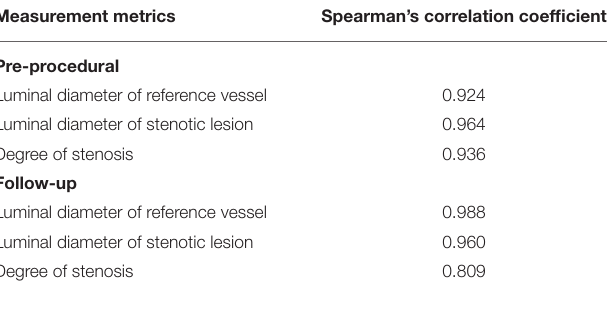
TABLE 4 | Summary of agreement between TOF-MR or HR-MR images and DSA. Measurement